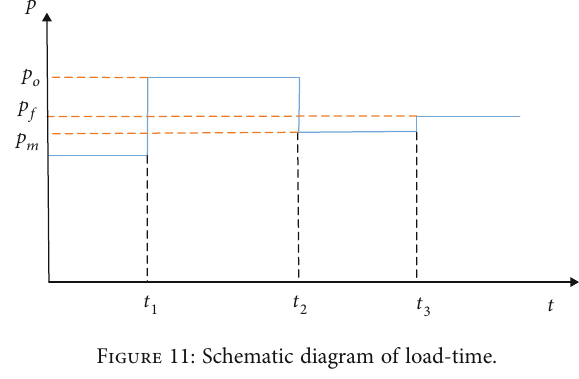
Figure 11: Schematic diagram of